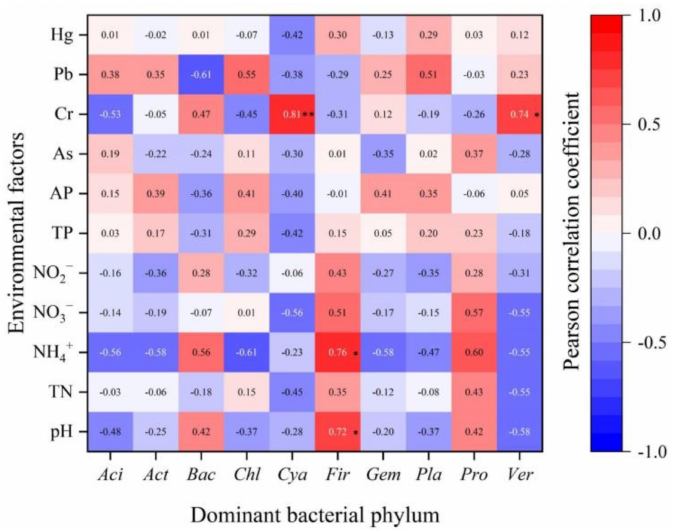
Figure 5. Pearson correlation analysis between environmental factors and dominant phylum of bacterial community in sediments. (Note: * indicates significant correlation at 0.05 level and ** in- dicates significant correlation at 0.01 level. Aci : Acidobacteria ; Act : Actinobacteria ; Bac : Bacteroidetes ; Chl : Chloroflexi ; Cya : Cyanobacteria ; Fir : Firmicutes ; Gem : Gemmatimonadetes ; Pla : Planctomycetes ; Pro : Proteobacteria ; Ver : Verrucomicrobia.